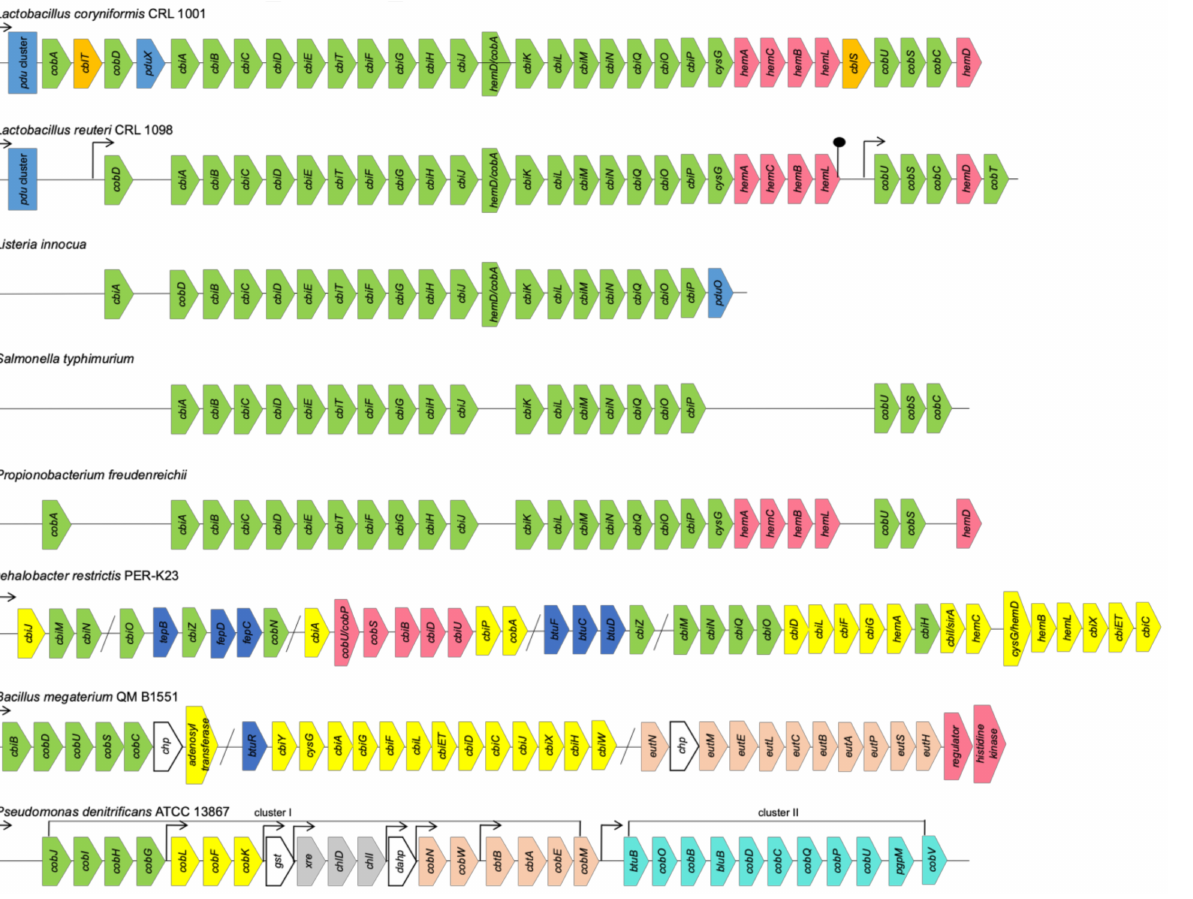
Figure 2. Genetic organization of B12 biosynthesis in different bacteria. The genes are indicated by colorful arrows; fine arrows denote confirmed promoters; hairpins symbols denote confirmed terminators